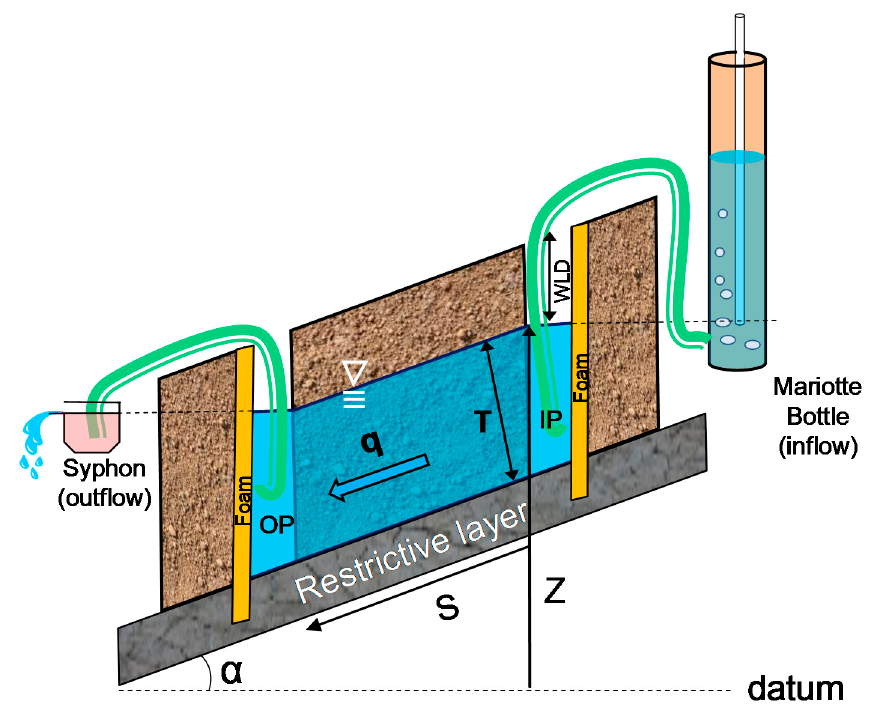
Figure 2. Experimental design to estimate the lateral saturated hydraulic conductivity of soil horizons from drainage of large-volume soil monoliths. The sketch represents the syphon system used in the MA, MB and MC monoliths to set the water levels and collect the drainage.